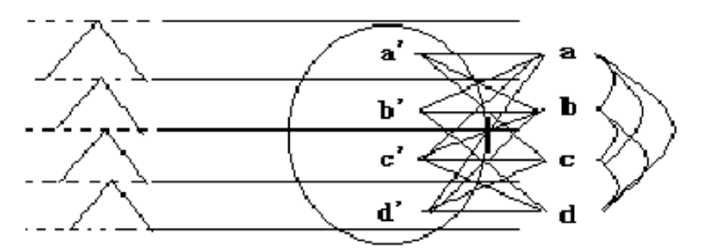
Figure 3. Layers and